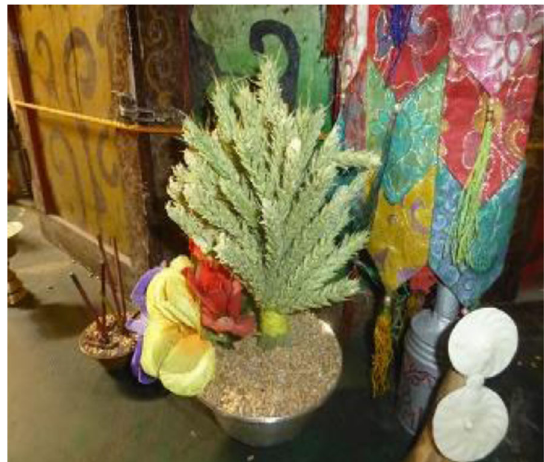
Fig. 8 Newly harvested crop offered to the local